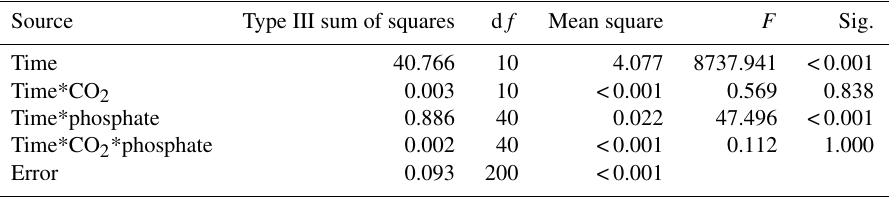
Table 4. Repeated measurements of analysis of variance for the effects of CO 2 and phosphate on pH change during 10h of incubation. Time*CO 2 means the interactive effect of incubation time and CO 2 . Time*phosphate means the interactive effect of incubation time and phosphate. Time*CO 2 *phosphate means the interactive effect of incubation time, CO 2 , and phosphate. d f means degree of freedom, F means the value of the F statistic, and Sig. means the p